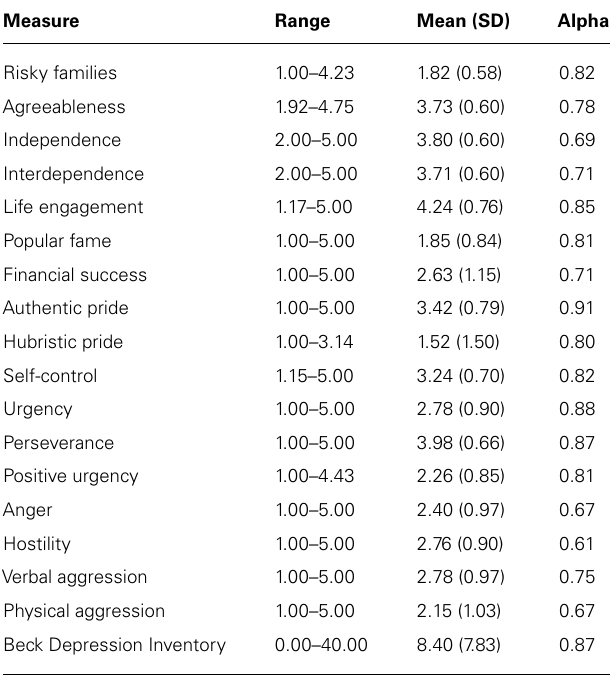
Table 1 | Descriptive statistics on self-reports